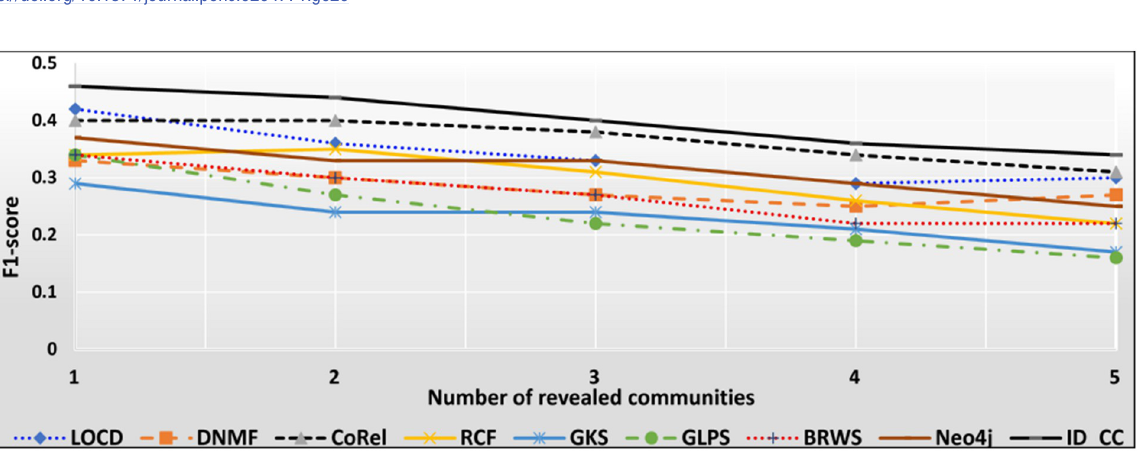
Fig 27. The accuracy of each method in terms of F1-score for detecting the Friendster cross-communities resulted from the overlapping of m number of communities ( m = 1, 2, ... , 5).